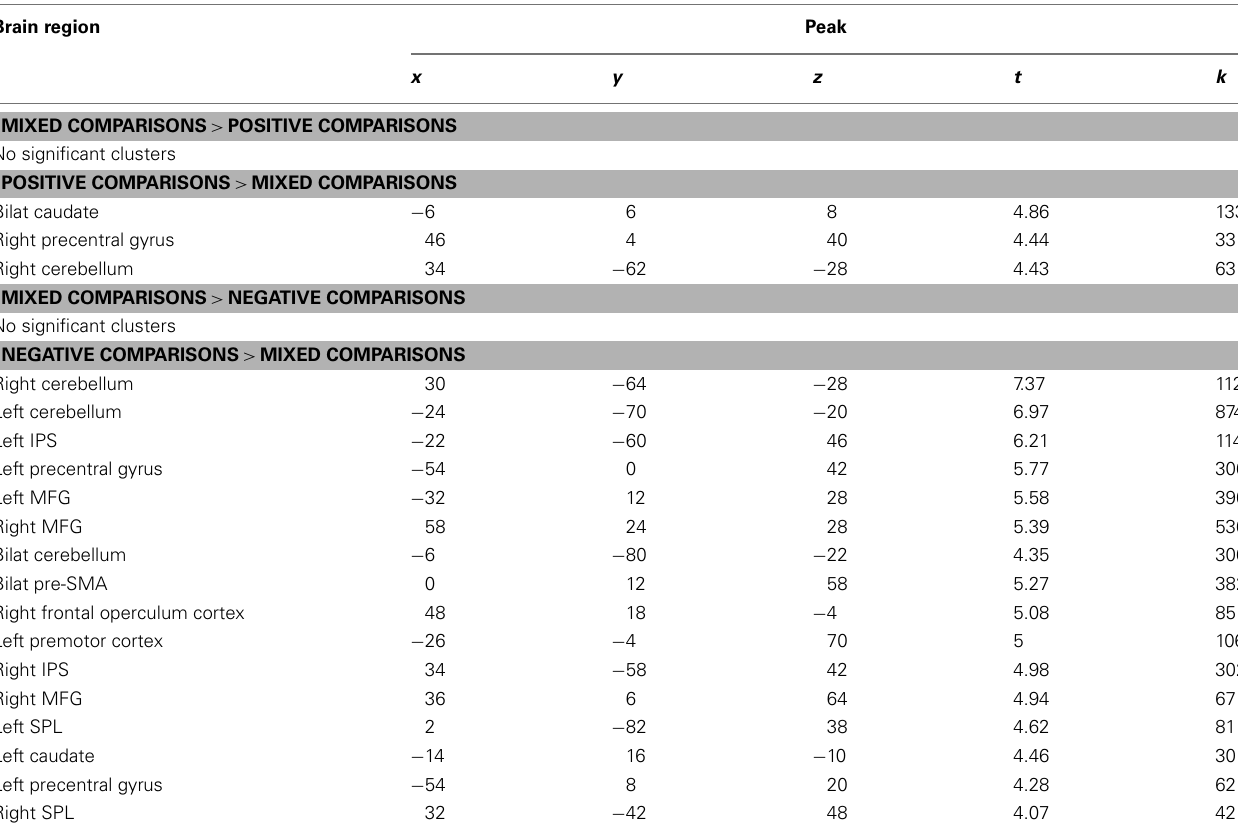
TableA1 |Activation differences between mixed comparisons and positive and negative comparisons. Brain region